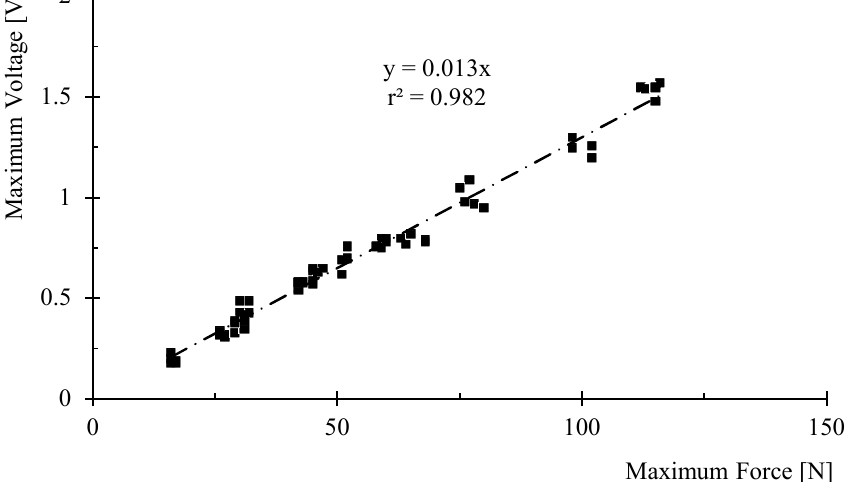
Figure 8. The dependence of the measured maximum voltage U max on calculated mean impact force F mean for the home-made PVDF sensor (12 mm × 30 mm).